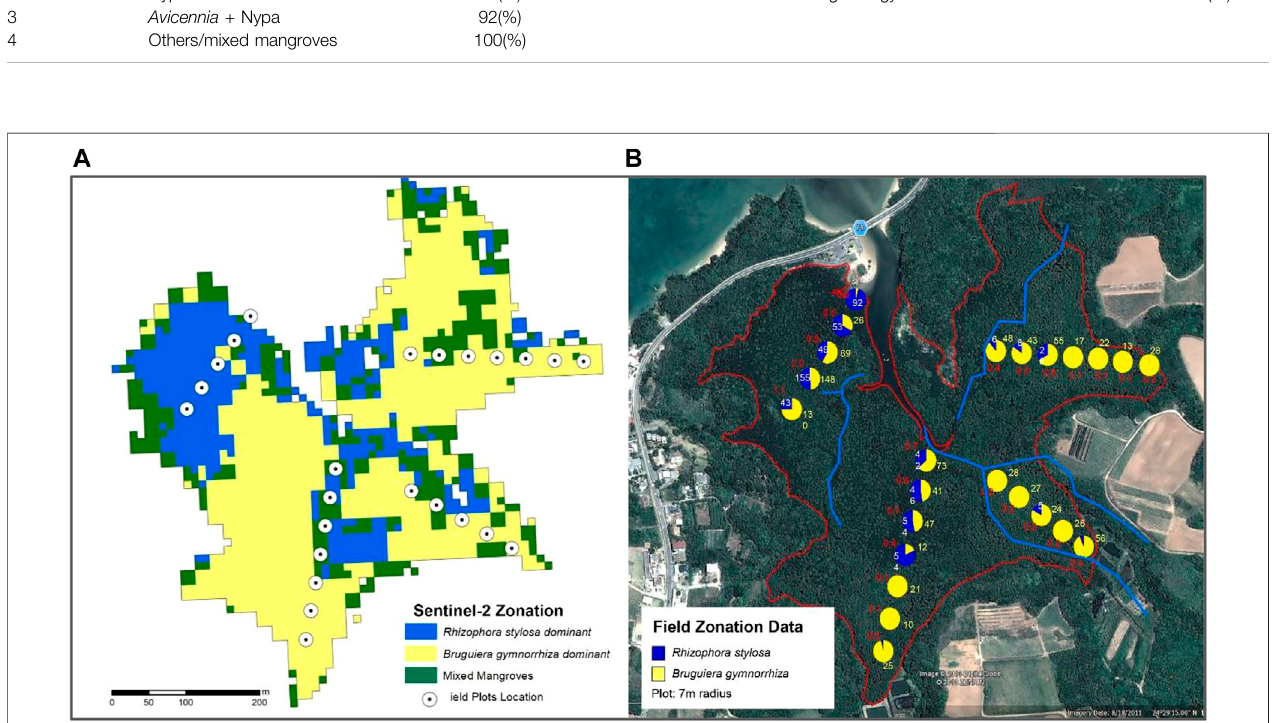
FIGURE6| Sidetosidecomparisonbetweenthe fi eld-acquiredmangrovespecies-zonationdata (B) andSentinel-2basedzonationmap (A) generatedforFukido Mangrove Park. Similar colors were assigned to each mangrove species for both data. There are two dominant species and a mixed zone.